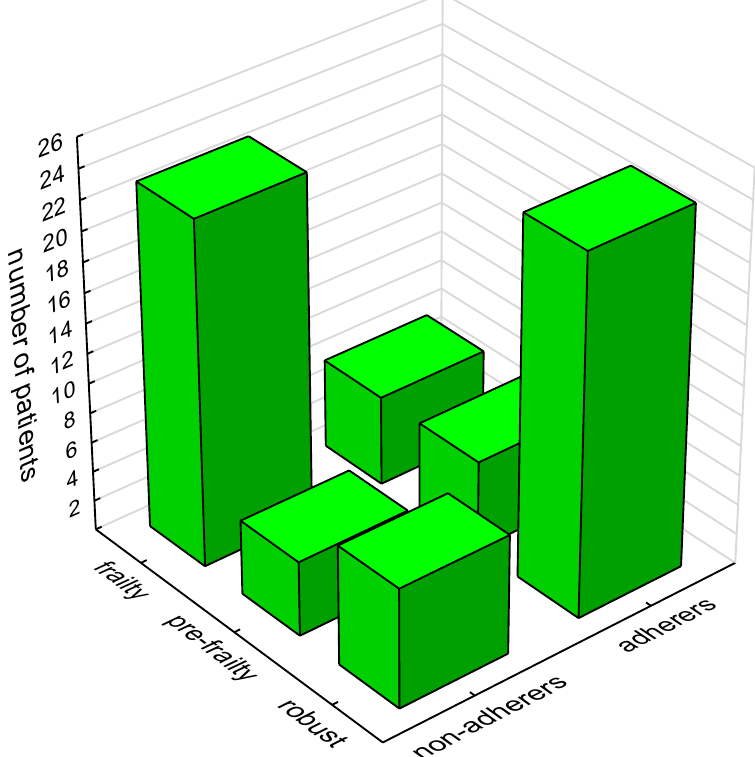
Figure 1. Influence of frailty on adherence to physical activity